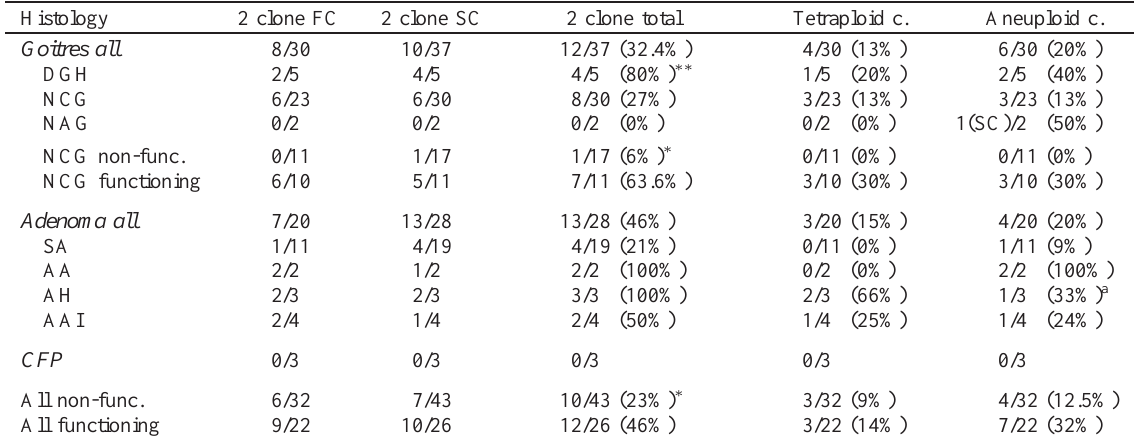
Table 1 Presence of biclonality, aneuploidy and polyploidy of the whole series